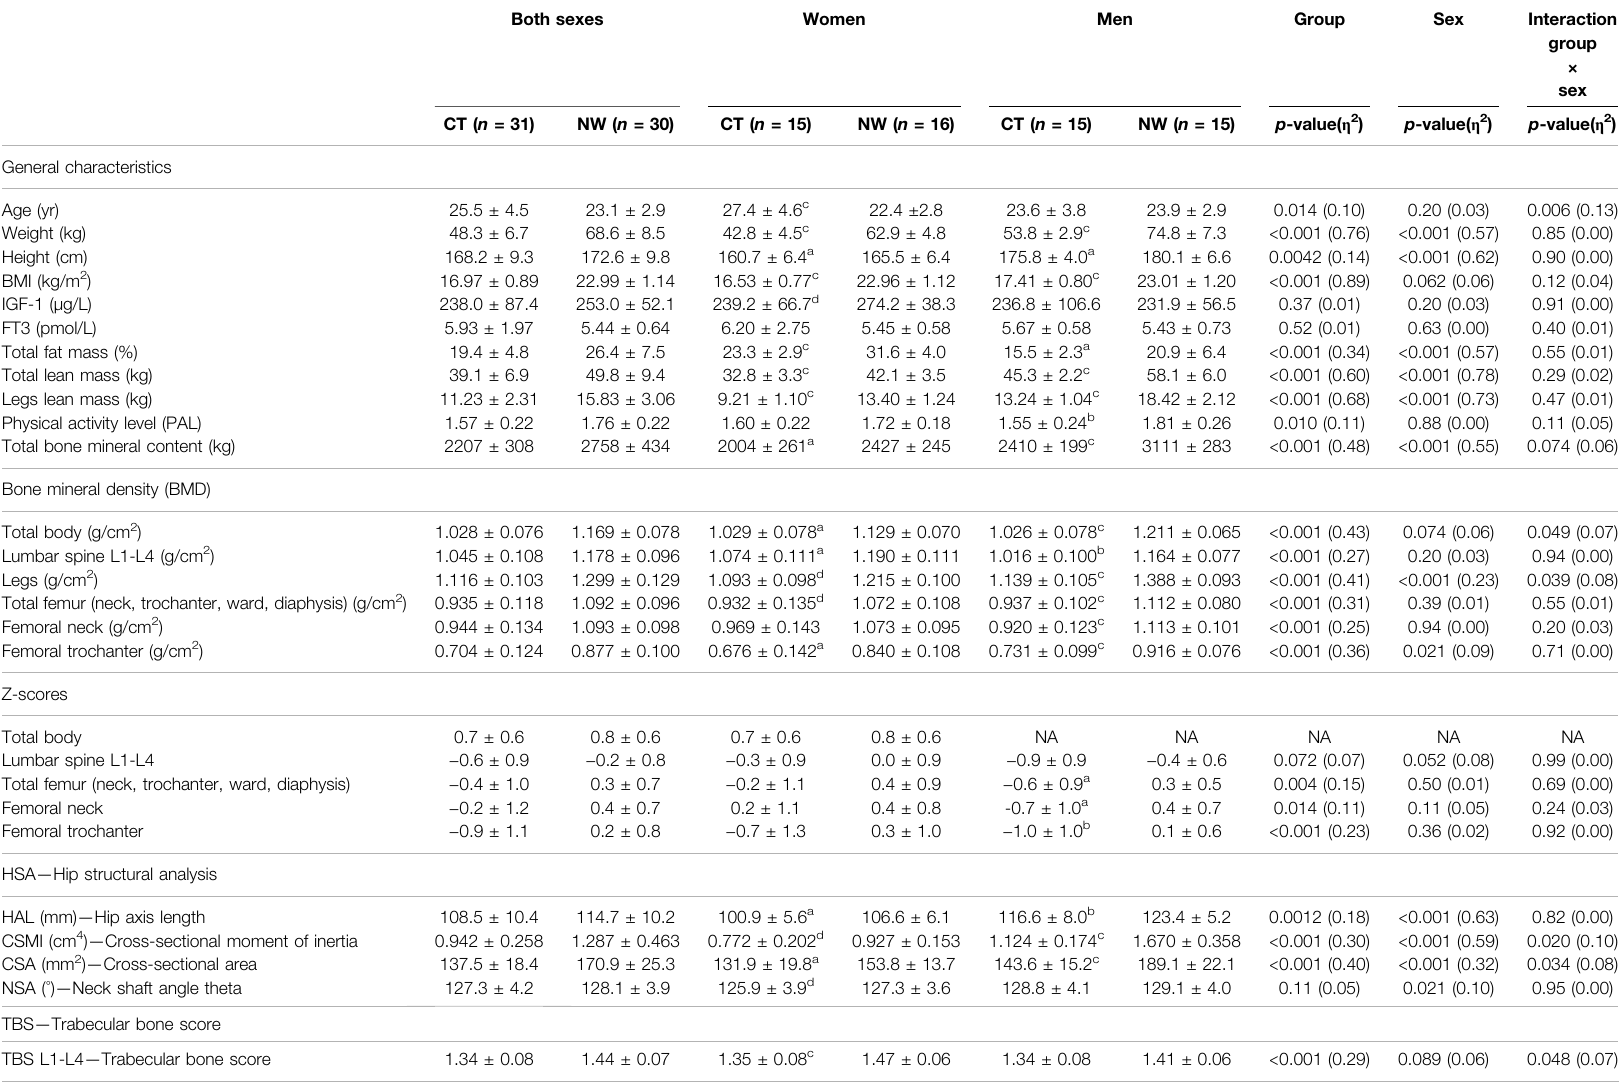
TABLE 1 | Anthropometry, body composition, densitometry, bone geometry and bone texture in women and men with constitutional thinness compared with normal weight controls. Both sexes Women Men Group Sex Interaction